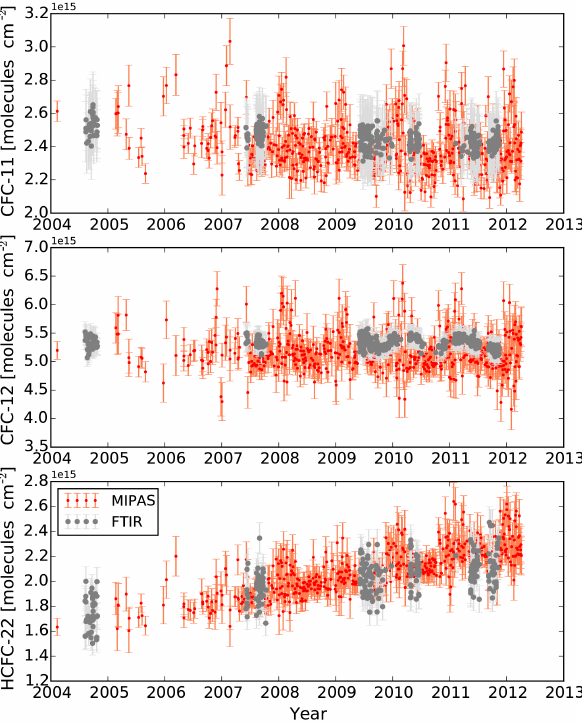
Figure 7. The time series of the individual partial columns (6– 30km) of CFC-11, CFC-12 and HCFC-22 from St Denis FTIR measurements (grey) and raw MIPAS data (red). Error bars repre- sent the retrieval